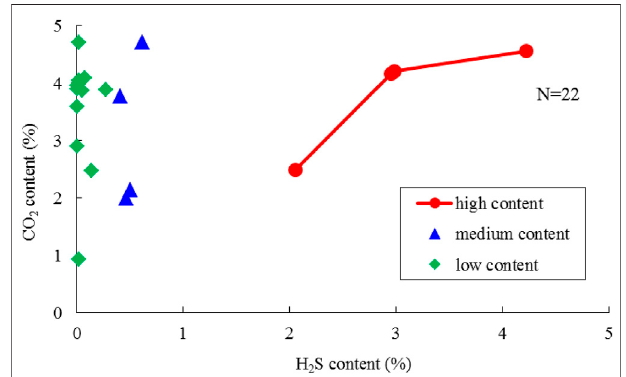
FIGURE 9 | Relationship between CO 2 and H 2 S